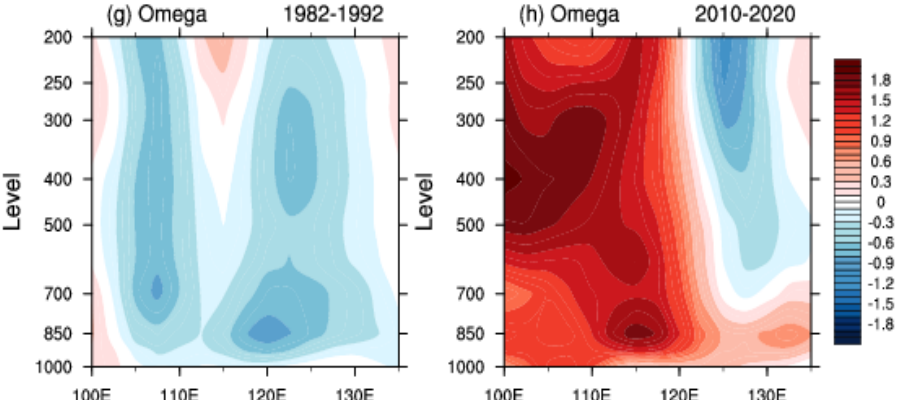
Figure 8. Composite patterns of anomalies of the 10m wind (unit: m s − 1 ) in the warm season of 1982–1992 ( a ) and 2010–2020 ( b ); total cloud cover in the warm season of 1982–1992 ( c ) and 2010–2020 ( d ); net shortwave heat fluxes (unit: W/m 2 ), defined as positive downward (into the ocean) in the warm season of 1982–1992 ( e ) and 2010–2020 ( f ); Longitude-height cross-section of anomalies (color shading) of vertical velocity (omega, unit: Pa/s) in 1982–1992 ( g ) and 2010–2020 ( h ) warm season (a positive value means sinking motion) along 12.5 ◦ N. Anomalies are relative to the mean from 1983–2012.